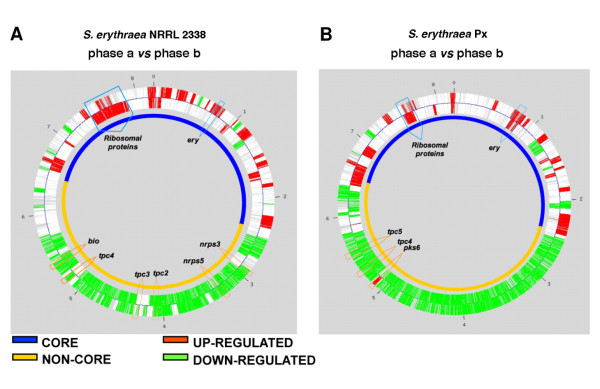
Visualization of the LAP algorithm results on the two chromosome strands independently analyzed. Comparison between the transcriptional profiling of all the 6494 S. erythraea genes in phase A versus phase B in the NRRL2338 strain(A) and in the Px strain(B) is shown. A q value of 0,01 and a fold change of 0,5 were chosen as filtering parameters. The transcriptionally up-modulated regions are shown in RED while the down- modulated are in GREEN. The OriC is indicated as O and the resolution of the chromosome is 1 Mb. The core region is evidenced in blue and the non-core region in orange; the position of clusters involved in the secondary metabolism, erythromycin production and coding for ribosomal proteins are outlined by arrows.